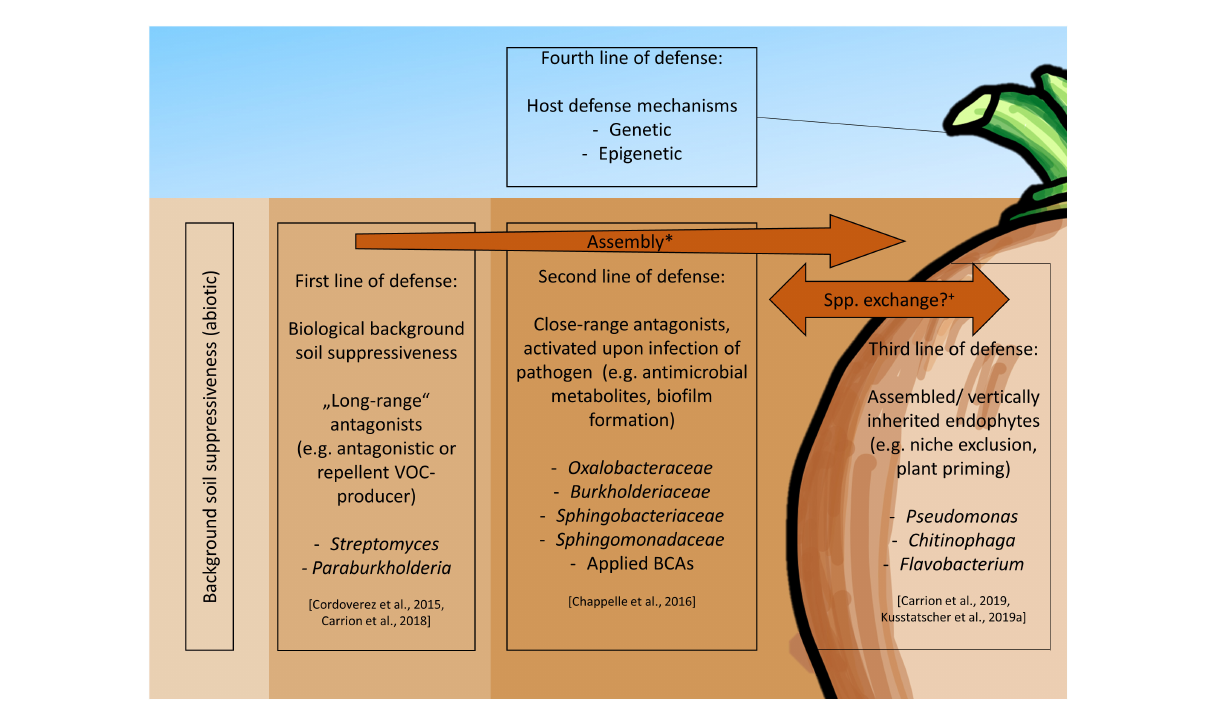
FIGURE2 Microbiome-based defense mechanism toward Rhizoctonia solani in sugar beet. *Root exudate-mediated enrichment of rhizosphere-associated microbes. + The deposition of initial seed endophytes from taproot toward the rhizosphere is not proven in sugar beet so far.